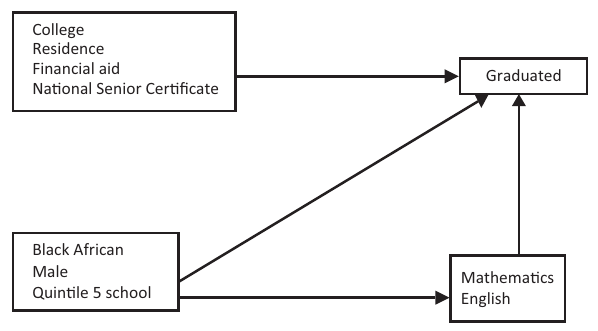
FIGURE 1: A structural equation model for graduation with direct and indirect mediated effects. TABLE 7: Direct effect estimates associated with graduation for the model structure given in Figure 1. Path